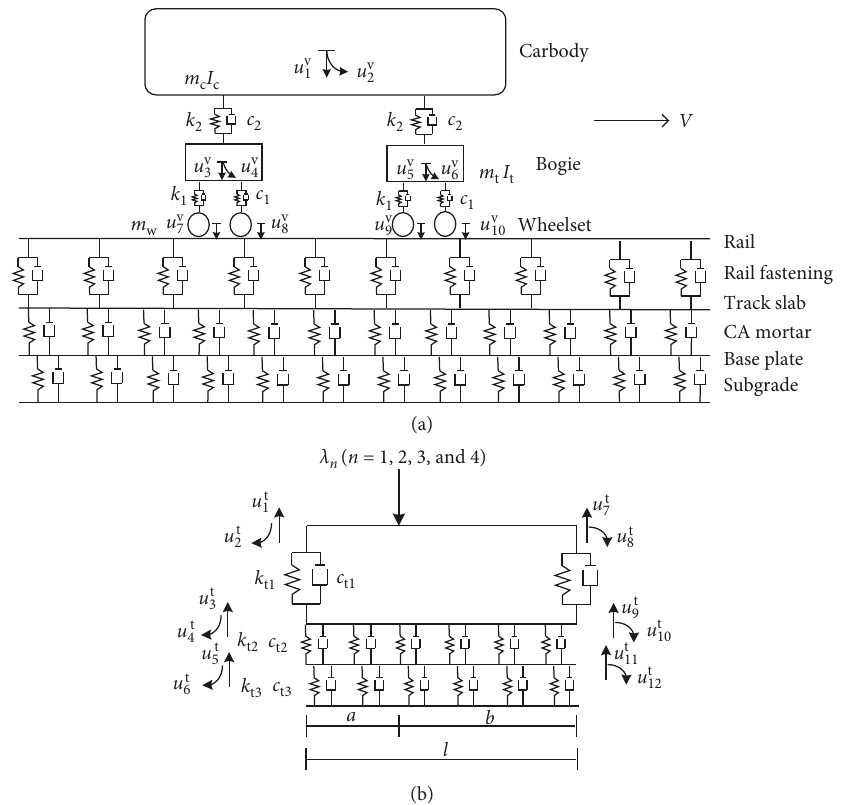
Figure 2: (a) Multiwheel vehicle and multilayer track-coupled model; (b) track element model.